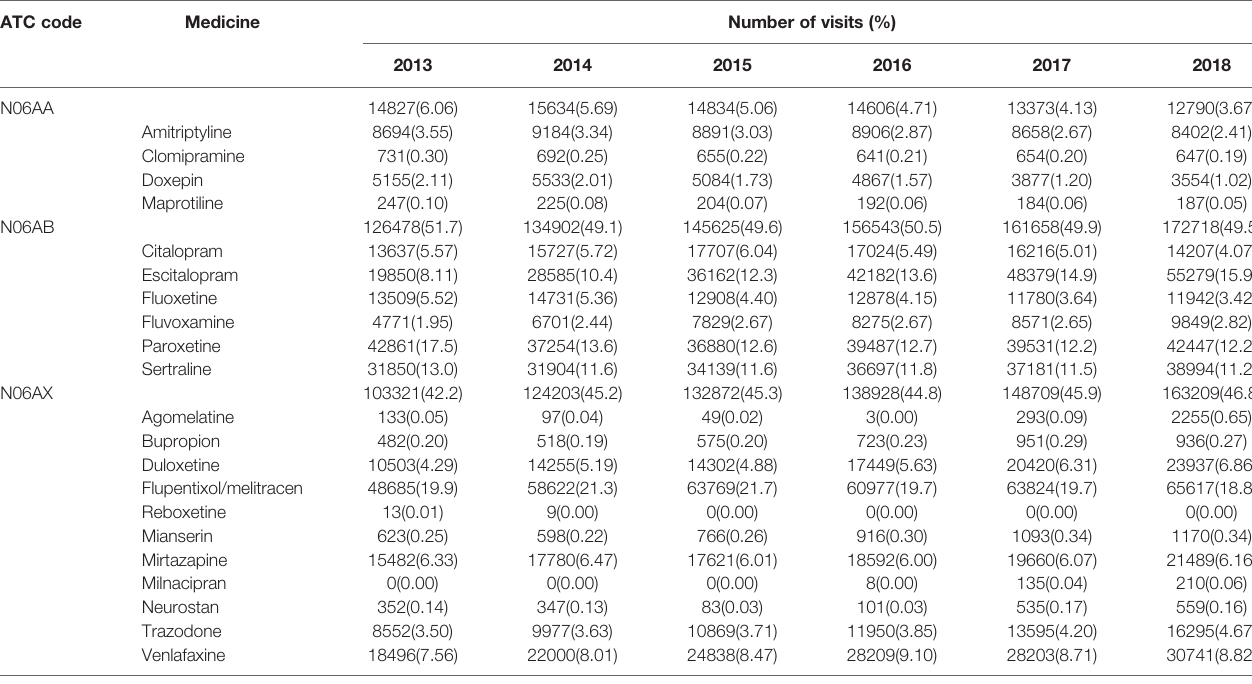
TABLE 2 | Antidepressant prescription visits by drug and drug class,